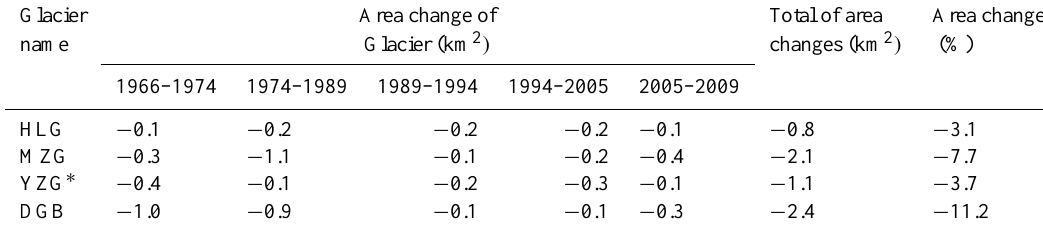
Table 6. Area changes of four typical glaciers. Glacier Area change of Total of area